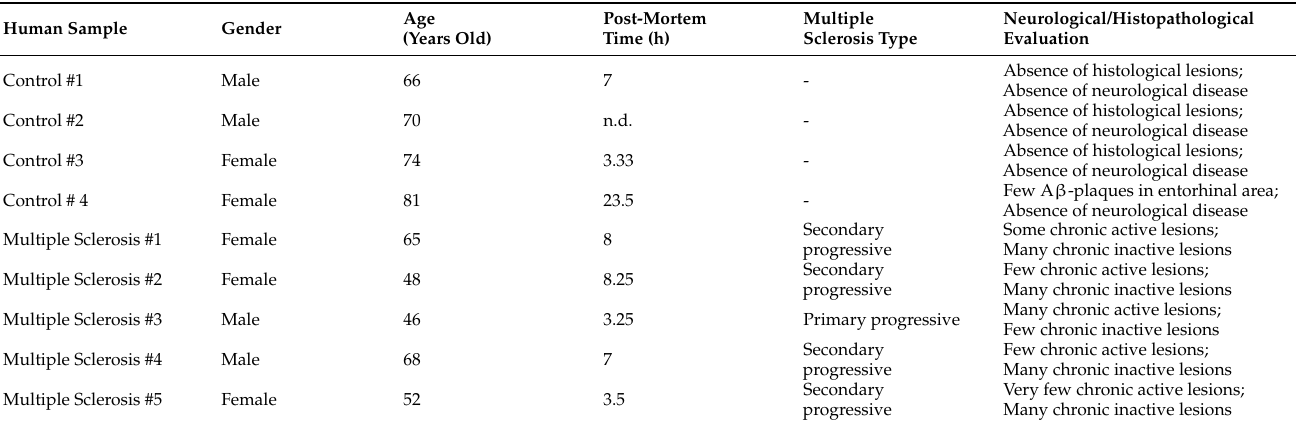
Table 1. Post-mortem human samples of frontal cortex obtained from healthy and MS